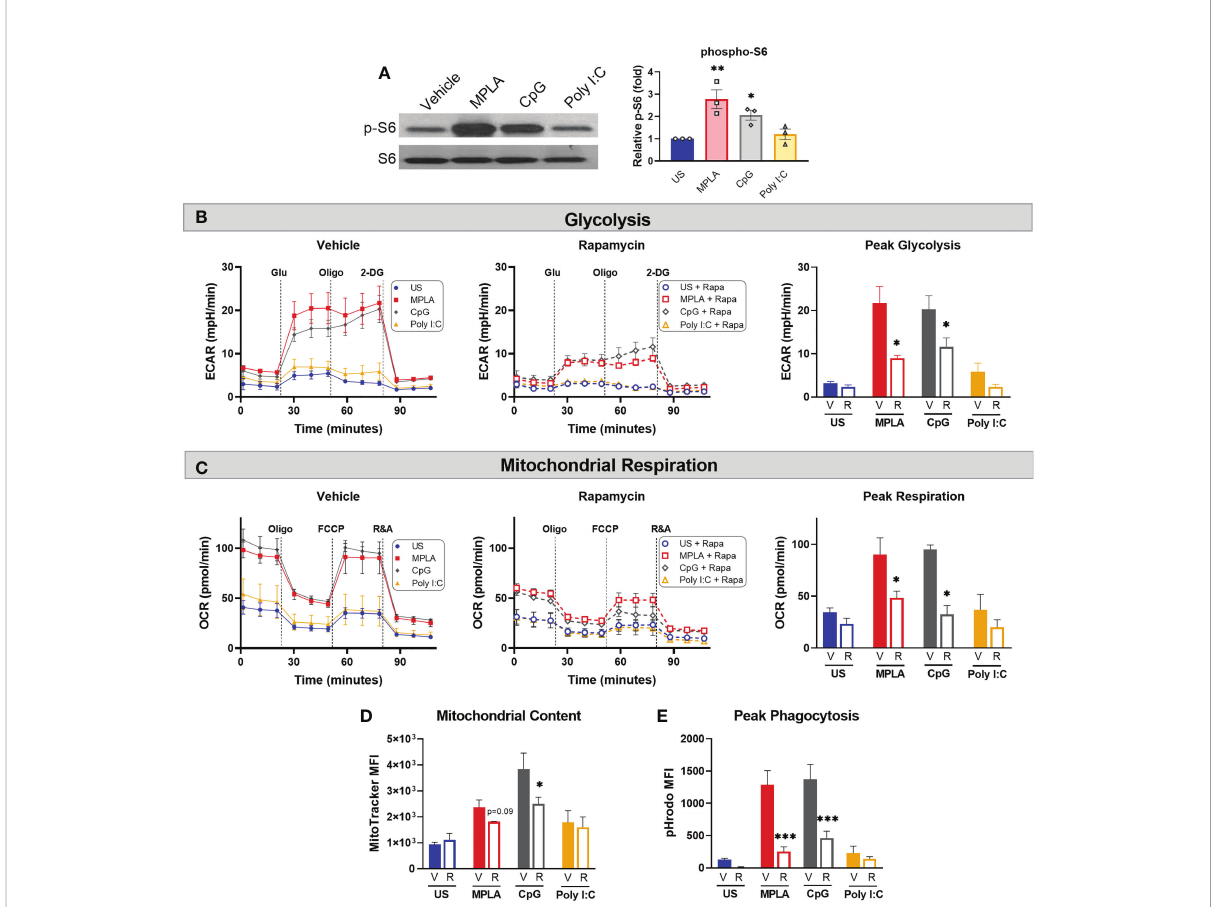
FIGURE 7 mTOR is a key mediator of TLR/MyD88-induced macrophage metabolic and functional reprogramming. (A) Western blotting of phosphorylated S6 kinase (p-S6) and total S6K (S6) on protein lysates from BMDMs treated for 24h with the TLR agonists (1 µg/mL for MPLA and CpG, 10 µg/mL for Poly I:C) compared to unstimulated negative controls (left). Blots are representative of three repeated experiments which were quanti fi ed by densitometry analysis (right). (B-E) BMDMs were treated with 100 nM Rapamycin (R) or vehicle (V) 1h prior to the addition of TLR agonists which remained in culture until washed off 24h later and cells were rested for 3 days prior to assays. (B) Glycolysis stress test was performed using Seahorse Xfe96 which measured extracellular acidi fi cation rate (ECAR) for vehicle-treated (left) and rapamycin-treated (middle) BMDMs, and peak glycolysis was analyzed (right). (C) Mitochondrial stress test was performed under the same experimental parameters as glycolysis stress test, and oxygen consumption rate (OCR) is presented for vehicle-treated (left), rapamycin-treated (middle), and peak respiration was measured (right). (D) Mitochondrial content was assessed using MitoTracker Green staining. (E) Phagocytic capacity was indicated by fl uorescence emitted upon phagocytosis of pHrodo-tagged S. aureus bioparticles and analyzed at peak activity. Data are shown as mean ± SEM, n = 2-3/group *p < 0.05, **p < 0.01, ***p < 0.001 by ANOVA followed by Dunnett ’ s post-hoc multiple comparison